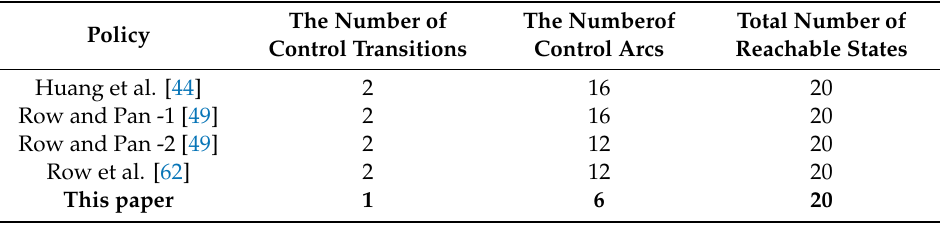
Table 8. Comparisons with existing literature in Example 1.